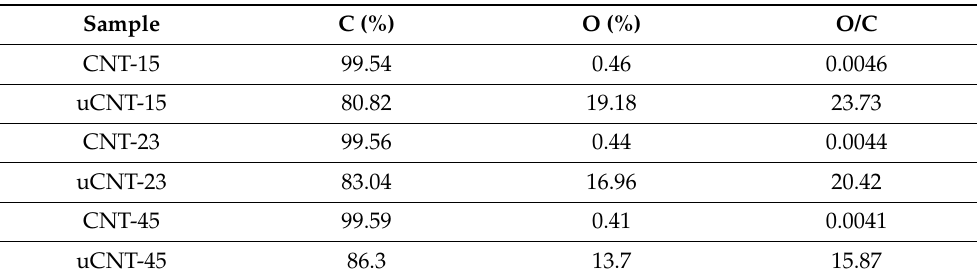
Table 3. Element percentage distributions of CNT-15, uCNT-15, CNT-23, uCNT-23, CNT-45, and